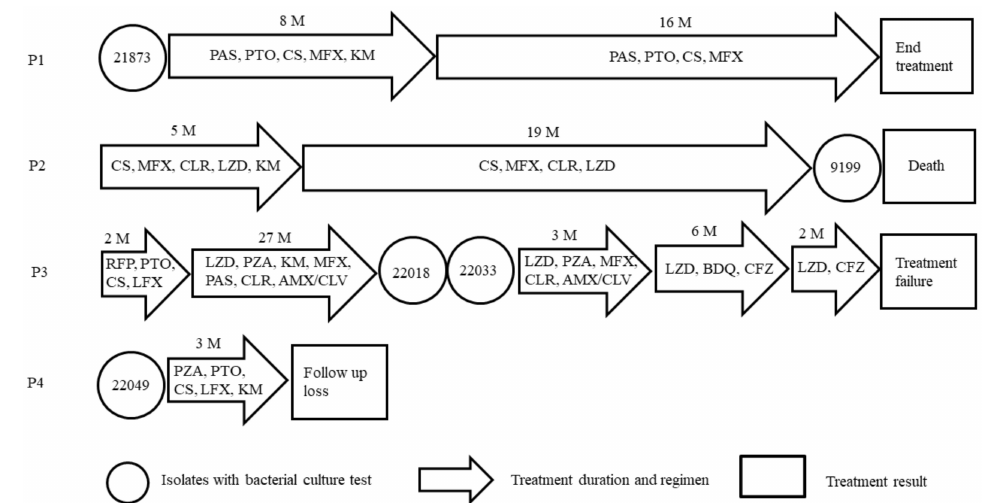
Figure 2. The treatment history and isolates of patients. M, month; AMX/CLV, amoxicillin/clavulanate; BDQ, bedaquiline; CFZ, clofazimine; CLR, clarithromycin; CS, cycloserine; KM, kanamycin; LZD, linezolid; MFX, moxifloxacin; PAS, para-aminosalicylic acid; PTO, prothionamide; RFP, rifampicin; PZA,